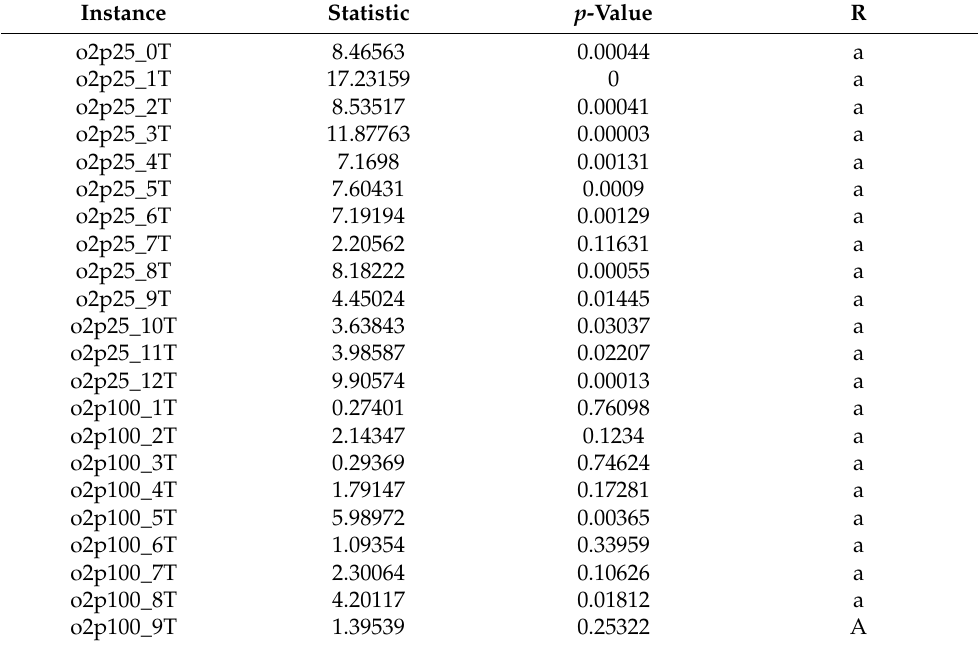
Table 7. Hypervolume homoscedasticity test, the null hypothesis is that all the input populations come from populations with equal variances, which is accepted (a) when p -value < 0.05 and rejected (r) otherwise. We can observe that the null hypothesis is accepted (a) for all the instances. The parametric t student test can be applied for all the instances that accept the null hypothesis in the normality tests.